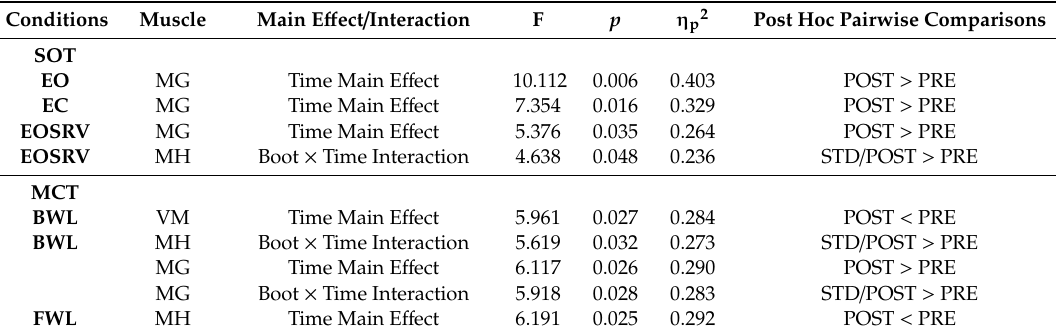
Table 2. Repeated measures ANOVA table for sensory organization test and motor control test.